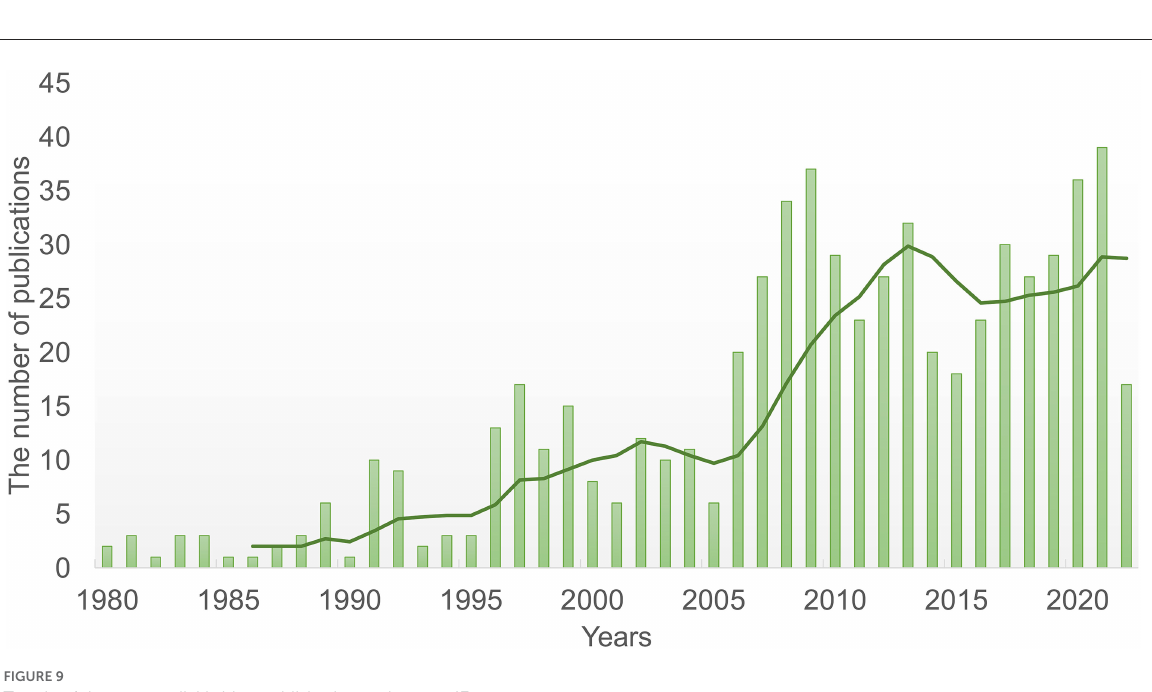
unroofing may be performed for patients with LAD-MB as an independent treatment with considerable improvement and no serious problems or fatalities in symptoms afterward